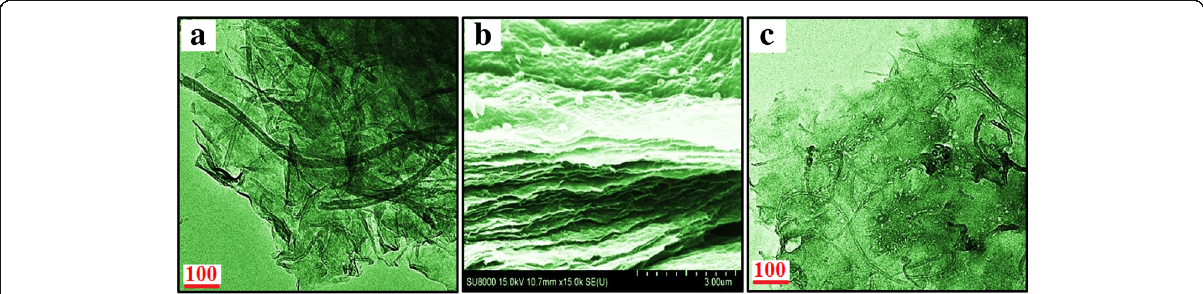
Fig. 11 a TEM images of the CP10C electrode before long cycle test and b FESEM and c TEM images of the CP10C after 15,000